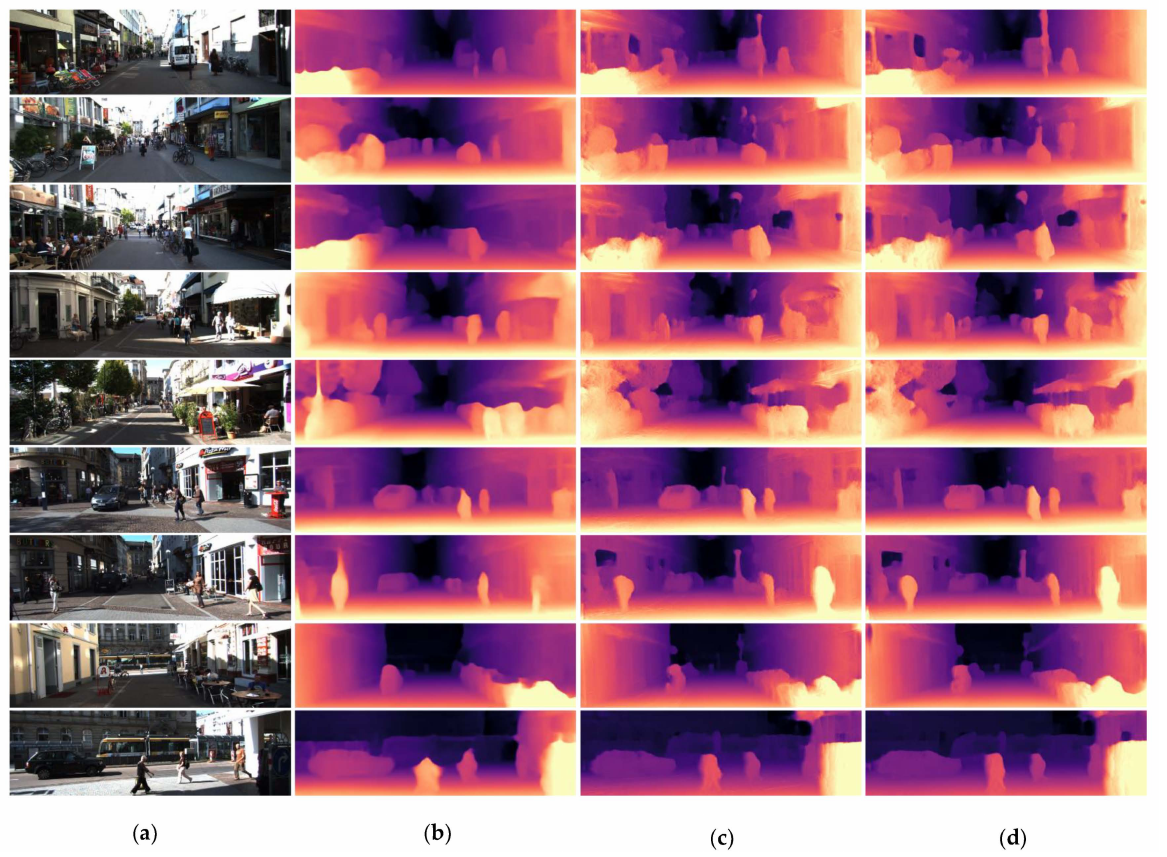
Figure 4. Qualitative results on the KITTI scene. ( a ) the primary image input; ( b ) generated result from the stereo depth estimator by Monodepth2 [3]; ( c , d ) are our results generated from 640 × 192 and 1024 × 320 models,